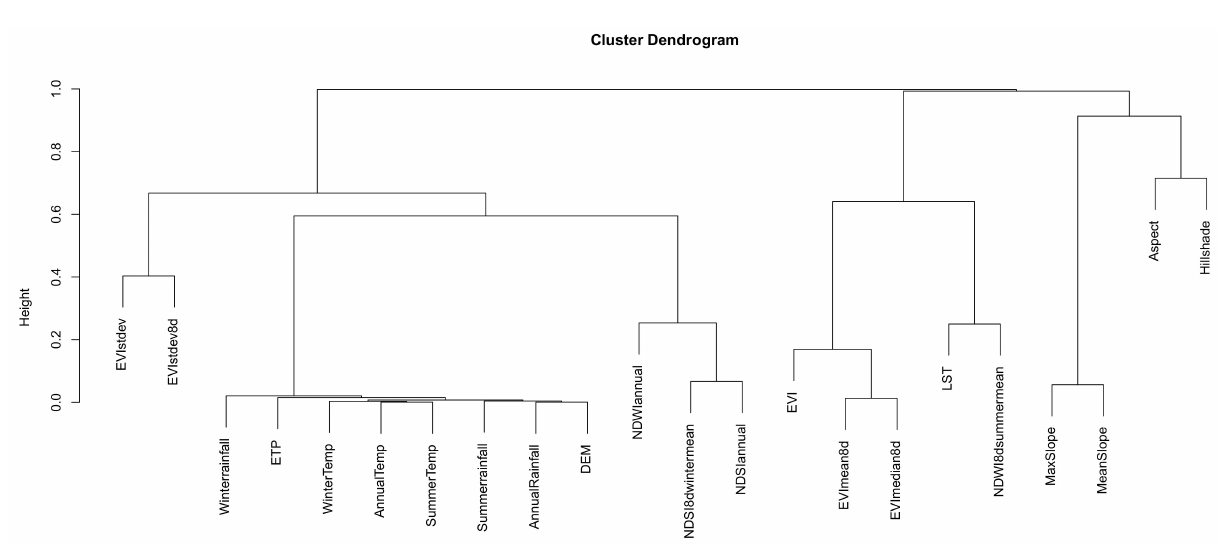
Figure A1. Cluster of correlation values obtained in the environmental variables VIF